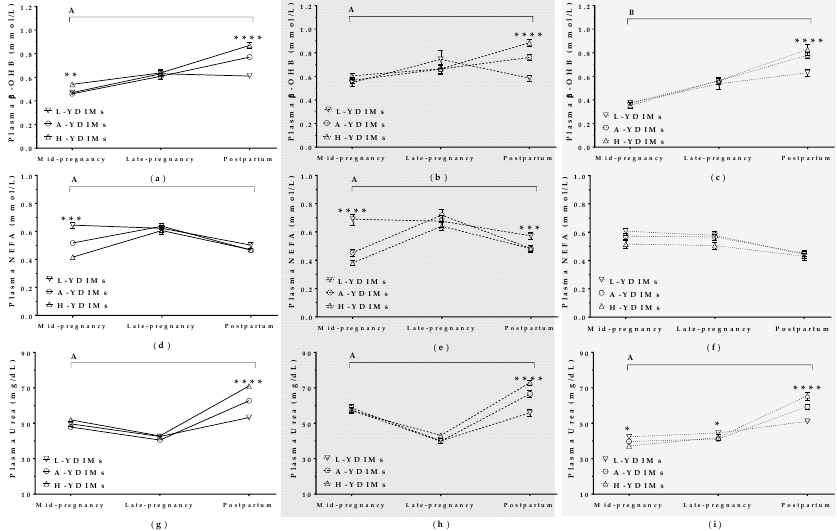
Figure 8. Plasma β -hydroxybutyrate levels in ( a ) all ewes, ( b ) mature ewes, and ( c ) maiden sheep showing high, average, or low milk yield at di ff erent stages of pregnancy and the postpartum period. Non-esterified fatty acids (NEFA) in ( d ) all ewes, ( b ) mature ewes, and ( f ) maiden sheep showing high, average, or low milk yield at di ff erent stages of pregnancy and the postpartum period. Urea in ( g ) all ewes, ( h ) mature ewes, and ( i ) maiden sheep showing high, average, or low milk yield at di ff erent stages of pregnancy and the postpartum period. L-YDIMs: low-yielding sheep with a YDIMs (daily milk yield during the first 6 months after lambing) of 1.17 L / d in average; A- YDIMs: average yielding sheep with a YDIMs of 1.90 L / d in average; H-YDIMs: high yielding sheep with a YDIMs of 2.70 L / d in average. Data are mean ± SEM. Significant interactions between stage of pregnancy / postpartum and YDIMs are represented by an upper horizontal line (A: p < 0.0001; B: p < 0.001) Asterisks indicate significant differences between groups at each time point (**** p < 0.0001; *** p < 0.001; ** p < 0.01; * p <